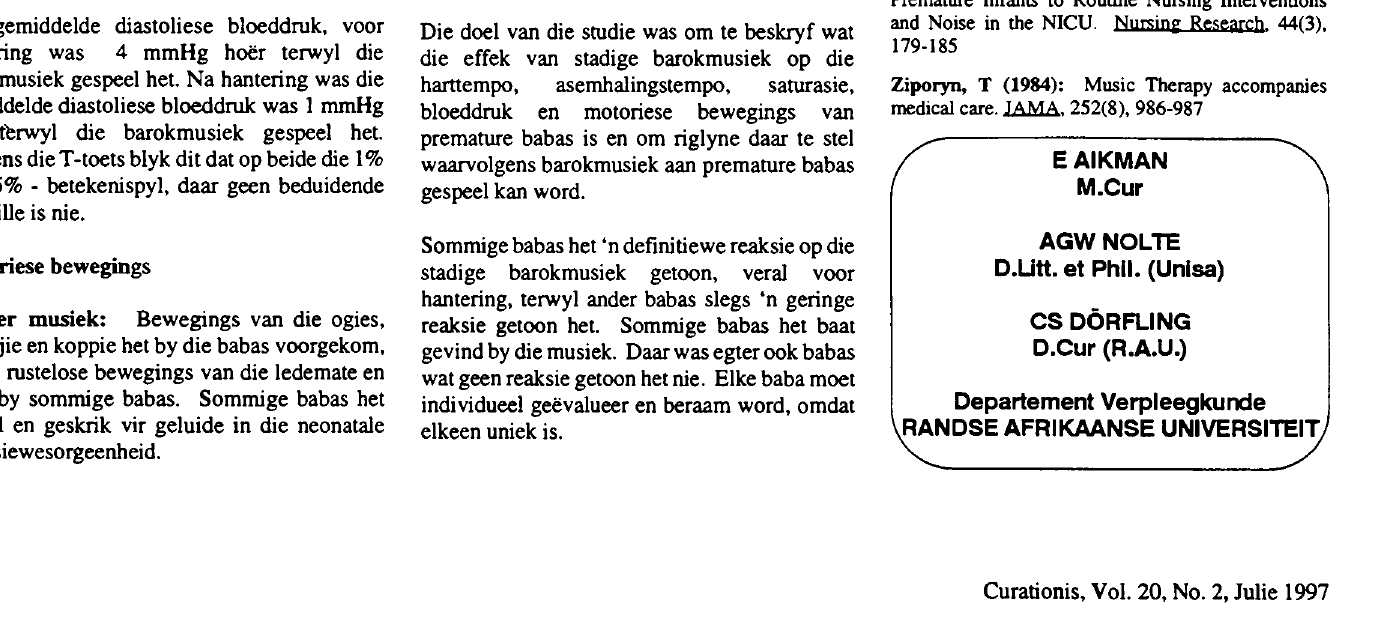
FIguur 10: Gemiddelde diastoliese bloeddruk van die babas na